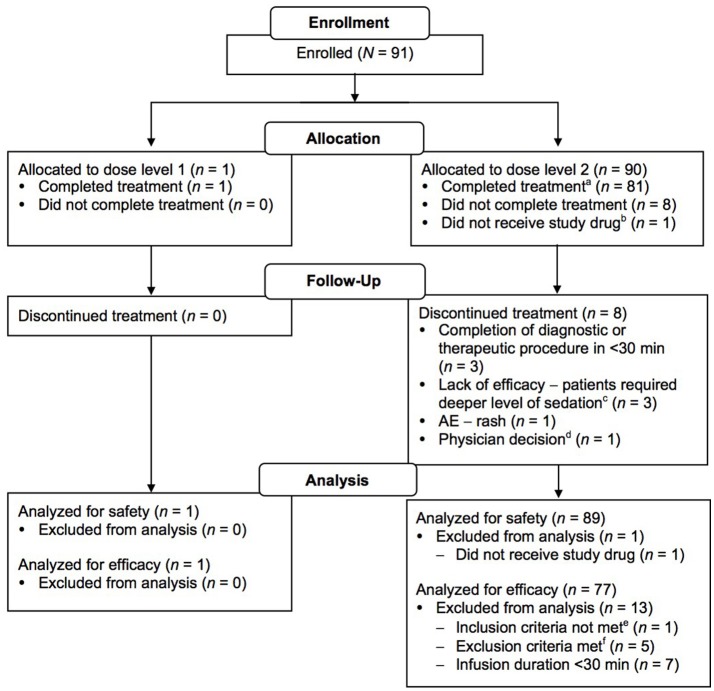
CONSORT diagram. aPatients who received study drug infusion for at least 30 min. bPatient was not treated due to administrative reasons (approval to prepare study drug could not be obtained within the 2-week period between enrollment and treatment). cPatients unable to be sedated adequately with protocol medications; converted to propofol sedation. dError in drug administration and clamp never released, no drug reached patient. Physician proceeded with alternative sedation. ePatient was <17 years of age. fThree patients had hypotension immediately before dosing; two patients had participated in an experimental/investigational drug study within 30 days prior to study drug administration.